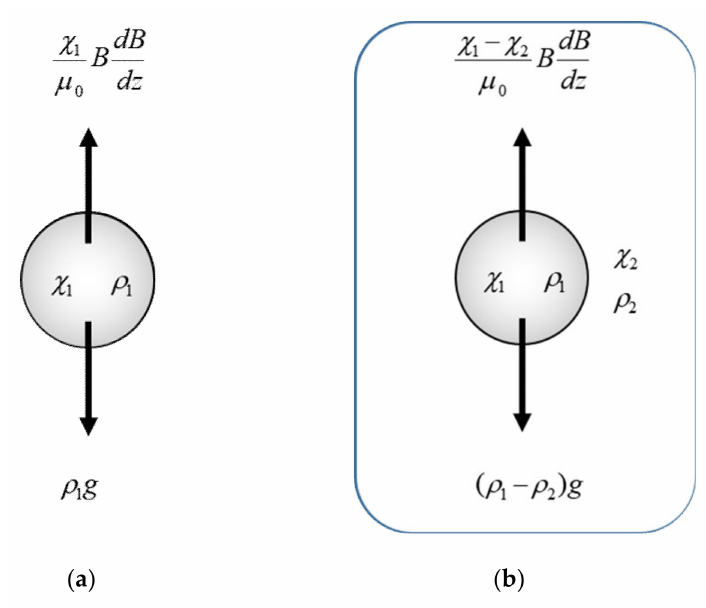
Figure 2. The force acting on a particle with susceptibility χ 1 and density ρ 1 levitating in ( a ) vacuum and in ( b ) a medium with χ 2 and ρ 2